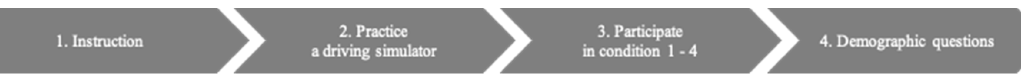
Figure 15. Mean Score and 95% Confidence Interval graph of SA and DMQ: ( a ) Mean score and 95% Confidence Interval of each SA level and ( b ) Mean score and 95% Confidence Interval of each dimension in DMQ (Source: Own creation).